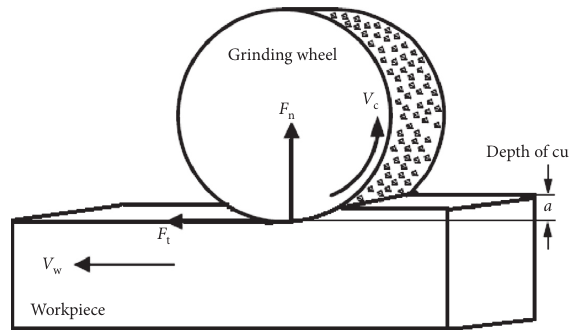
Figure 1: Schematic diagram of flat surface grinding vibration excitation forces.